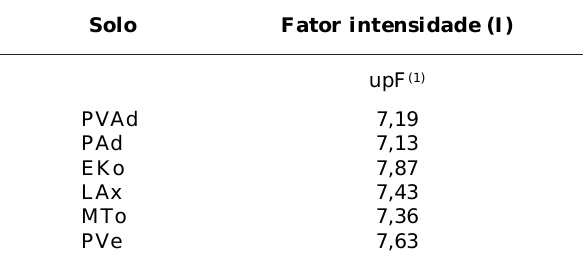
PO ), de solos de 2 4